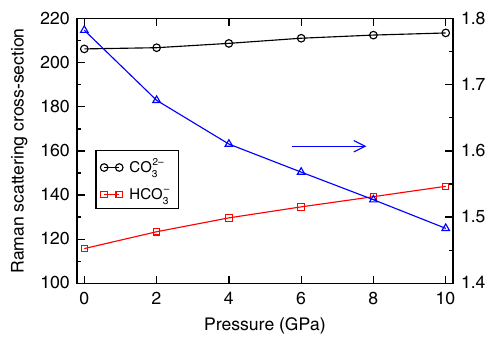
Fig. 7 Raman scattering cross-sections of carbonate and bicarbonate ions. We present results for the δ -Na 2 CO 3 (black line) and NaHCO 3 (red line) crystals as a function of pressure. The cross section ratios ), are shown as between these two ions, i.e., the γ ratio ( γ carb γ bicarb